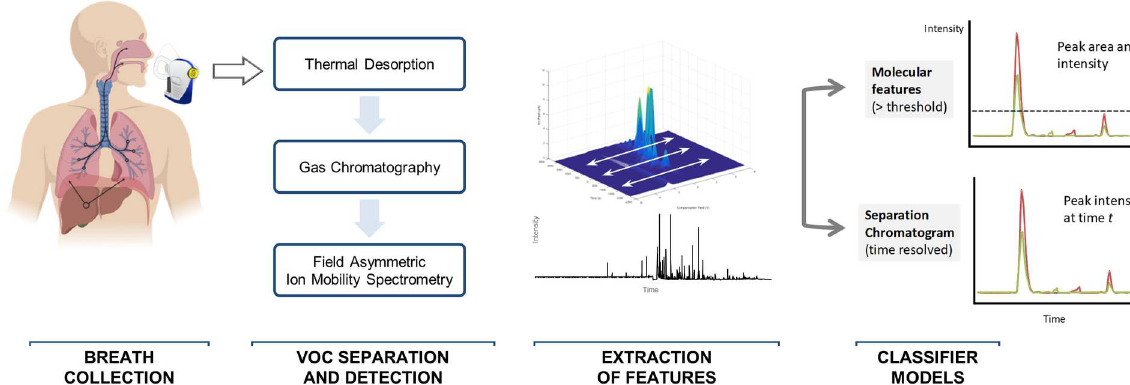
Fig 1. Collection and analysis of breath samples. Volatile organic compounds (VOC) in exhaled breath are collected onto thermal desorption tubes that pre-concentrate and focus analytes into a gas chromatography (GC) column for physical separation. Subsequently, VOC are further distinguished by field asymmetric ion mobility spectrometry that applies an alternating electric dispersion field with maximum voltage of 45V, 55V or 65V. Data output matrices for both positive and negative ions detected are preprocessed and the maximum ion peak intensity identified for each positive and negative ion resolved by GC retention time. Molecular features describe intensity resolved VOC defined by intensity greater than a threshold level, whereas separation chromatograms capture all VOC in a time-resolved manner. Differences in VOC output measured as molecular features or in separation chromatograms between controls (green lines) and disease states (red lines) are analyzed by machine learning to generate classifier models. Image generated with Biorender . com